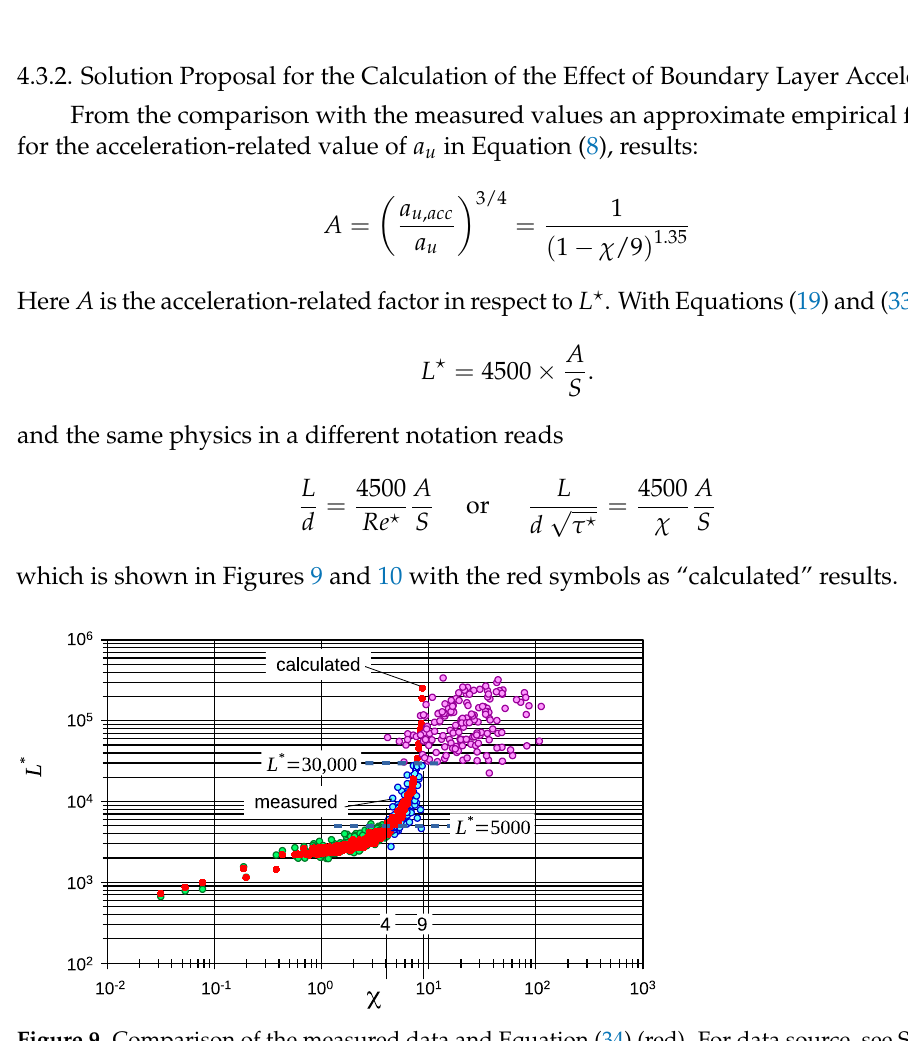
Figure 9. Comparison of the measured data and Equation (34) (red). For data source, see Section 3.